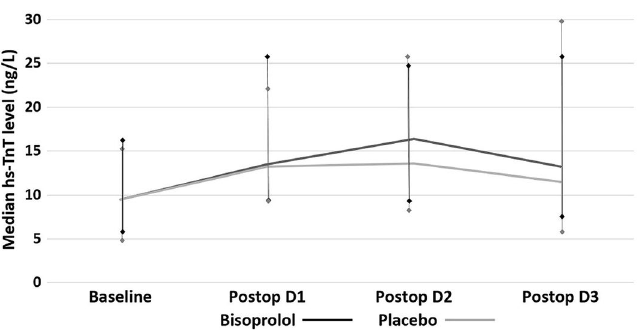
Figure 4. The effect of bisoprolol on median level of hs-TnT after surgery compared to placebo. There was no difference of median level of hs-TnT after surgery between bisoprolol (black line) and placebo (grey line)